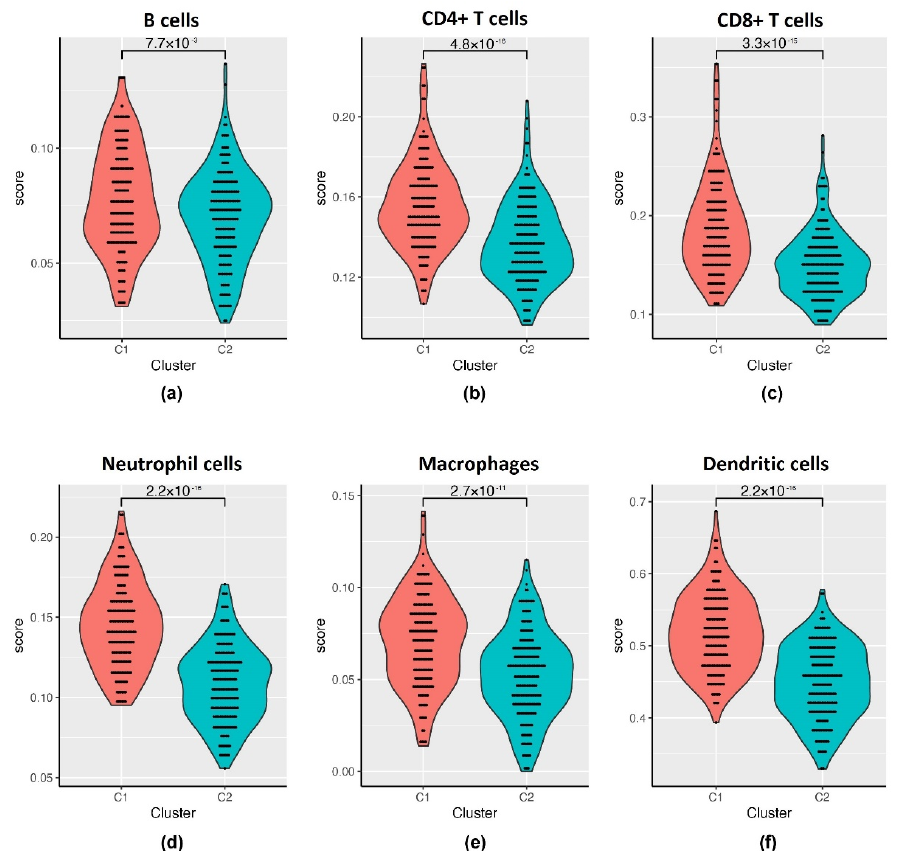
Figure 2. Tumor Immune Estimation Resource (TIMER) immune scores for cluster 1 (C1) and cluster 2 (C2) subtypes with the p -value in between for: ( a ) B cells; ( b ) CD4+ T cells; ( c ) CD8+ T cells; ( d ) neutrophil cells; ( e ) macrophages; ( f ) dendritic cells.